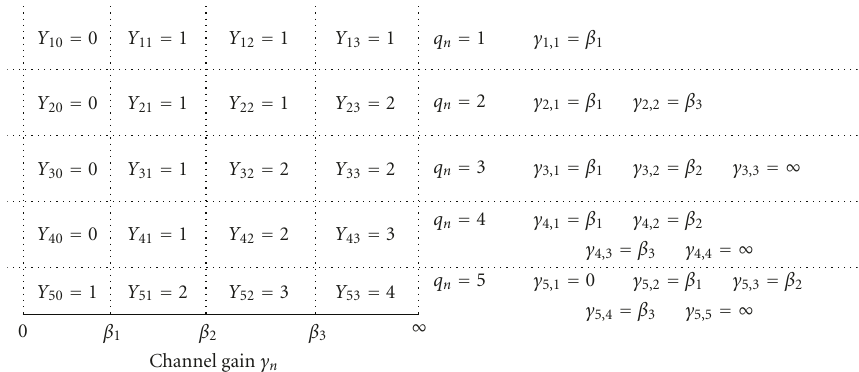
Figure 2: Examples of functions e ( q n ), g ( γ n , (cid:12) q n ), and f ( q n , (cid:12) γ n ) used when no TBIR or statistical TBIR is available. The corresponding γ ij values are also indicated. Number of feedback bits is N b = 2 and bu ff er length is L =